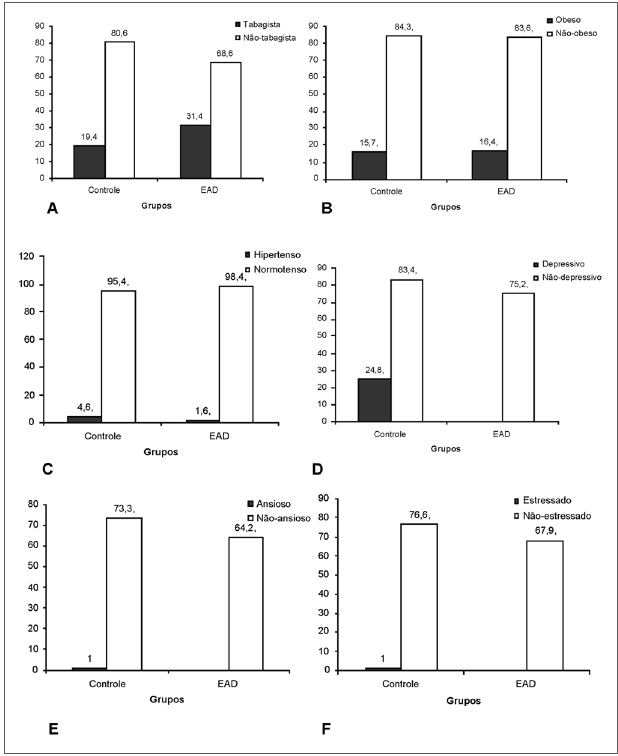
Figura 1. Comparação na distribuição de frequências de tabagismo (A), obesidade (B), hipertensão arterial sistêmica (C), autorrelato de depressão (D), autorrelato de ansiedade (E) e autorrelato de estresse (F) entre adultos jovens com EDA e sem alteração (controle). - EDA= Equilíbrio dinâmico